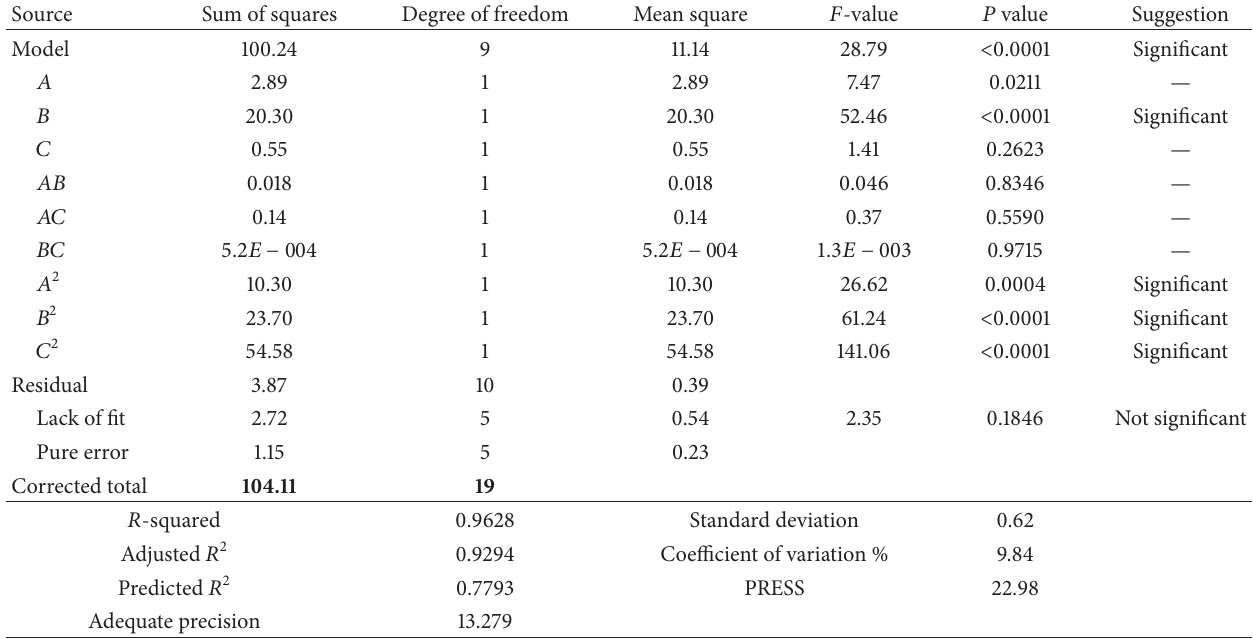
Table 3: ANOVA of quadratic